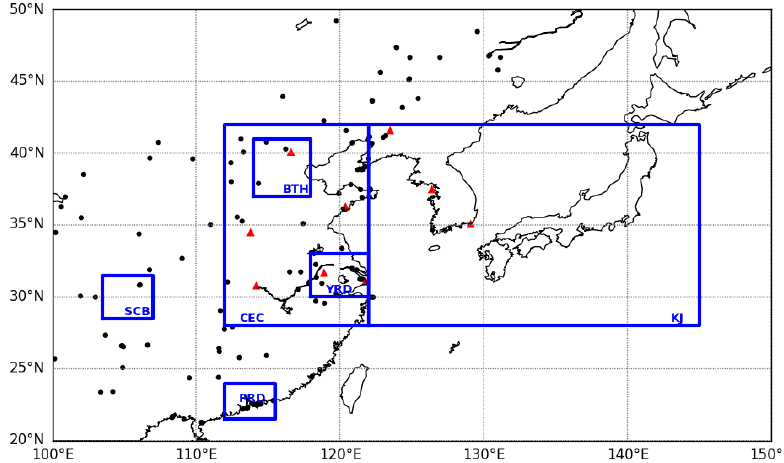
Figure 1. The northeastern Asian domain of the study. The following six subregions of interest are considered: Central East China (CEC; 28–42 ◦ N, 112–122 ◦ E), the Beijing–Tianjin–Hebei region (BTH; 37–41 ◦ N, 114–118 ◦ E), the Yangtze River Delta (YRD; 30–33 ◦ N, 118– 122 ◦ E), the Pearl River Delta (PRD; 21.5–24 ◦ N, 112–115.5 ◦ E), the Sichuan Basin (SCB; 28.5–31.5 ◦ N, 103.5–107 ◦ E), and the Korean Peninsula–Japan region (KJ; 28–42 ◦ N, 122–145 ◦ E). Black circles show the rural-type surface stations and the red triangles the IAGOS airports used in this